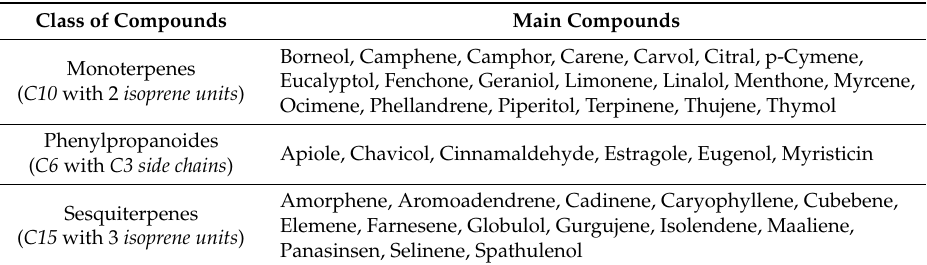
Table 2. The main classes of compounds found in the studied essential oils.